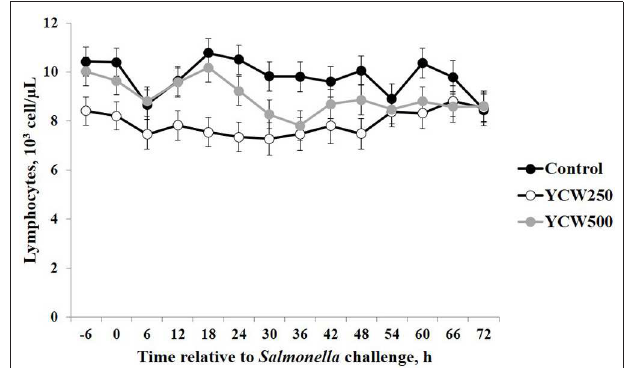
FIGURE 5 | Lymphocyte concentrations measured in pigs fed a control (Control) diet or supplemented with a yeast cell wall at 250 mg/kg (YCW250) or 500 mg/kg (YCW500), following administration of an oral Salmonella Typhimurium challenge on d 19.